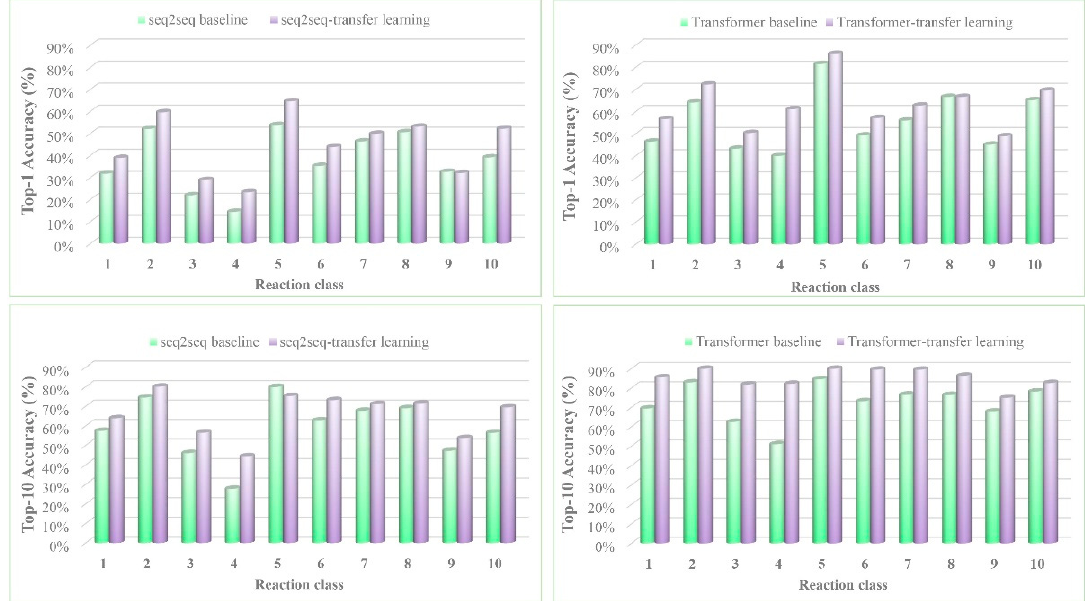
Figure 4. The top-1 and top-10 accuracies of the seq2seq/seq2seq-transfer-learning and Transformer/Transformer-transfer-learning models by reaction class. 1. Heteroatom alkylation and arylation. 2. Acylation and related processes. 3. C − C bond formation. 4. Heterocycle formation. 5. Protections. 6. Deprotections. 7. Reductions. 8. Oxidations. 9. Functional group interconversion (FGI). 10. Functional group addition